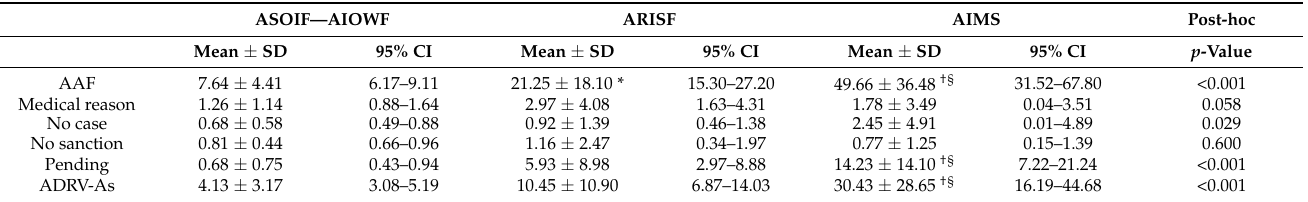
Table 4. Number of cases per 1000 anti-doping tests based on sport groups between 2013 and 2018. ASOIF—AIOWF ARISF AIMS